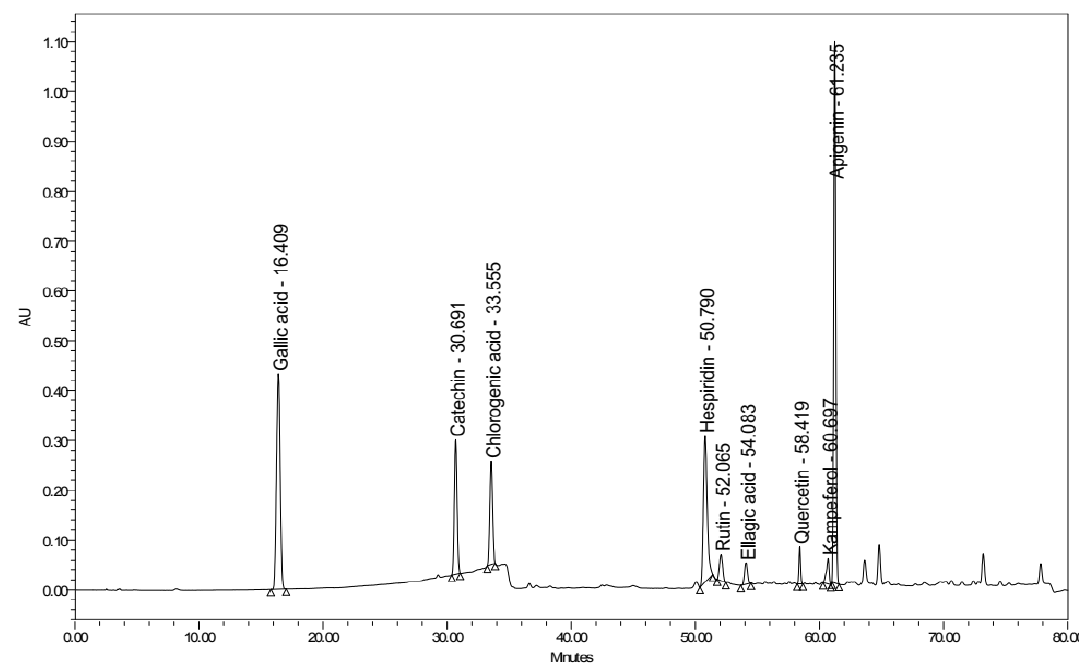
Figure 9. HPLC chromatogram of nine polyphenol reference standards at 280 nm.